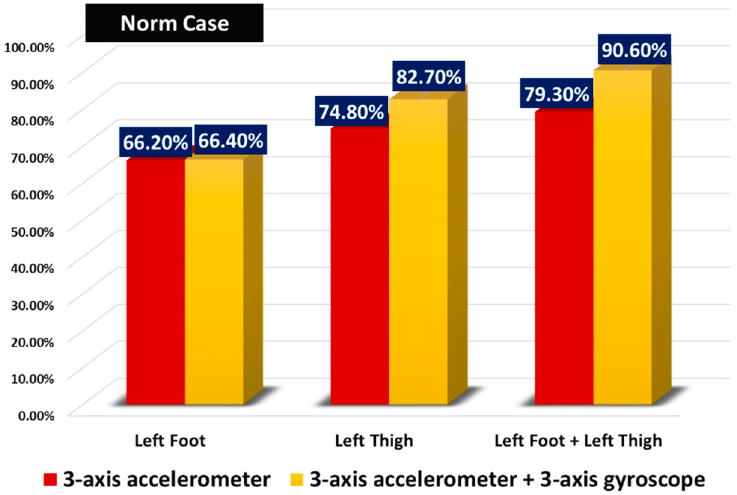
Figure 11. Recognition accuracies of static activities when using the norm of raw data as a feature.